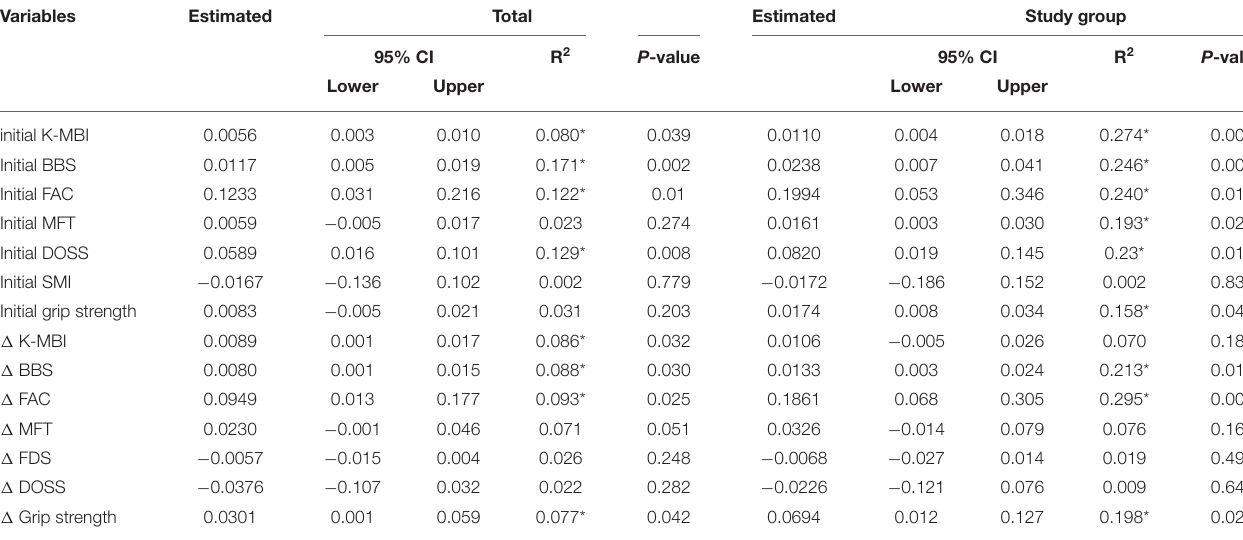
TABLE 4 | Univariate linear regression analysis related factors for changes in SMI (dependent variable: 1 SMI). Variables Estimated